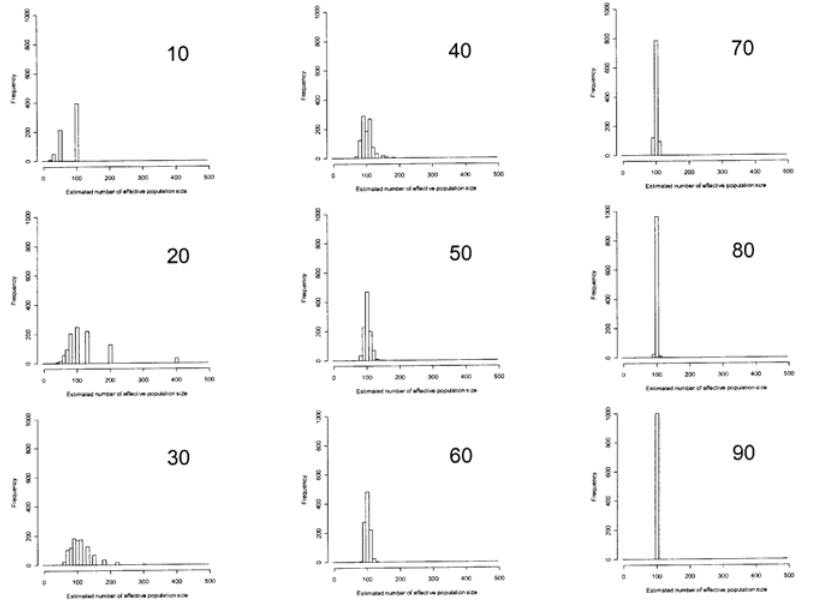
Fig. 2 The histograms of the estimated effective population size using the same number of samples (10, 20, 30, 40, 50, 60, 70, 80, 90) from each generation in computer simulations. The upper right number of each graph is the number of